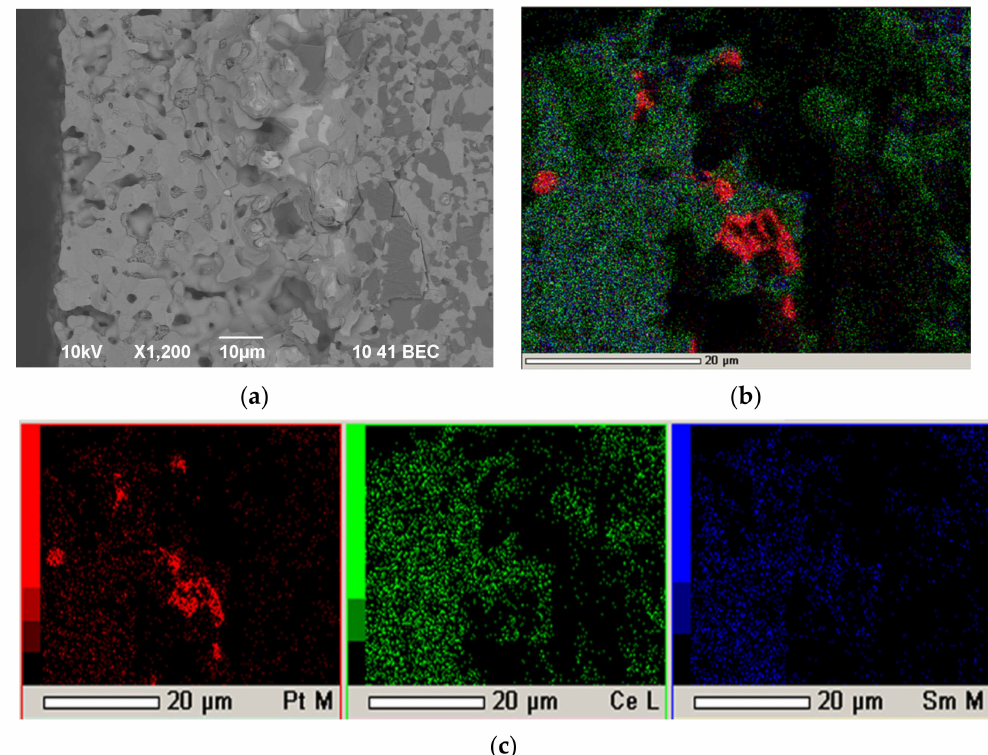
Figure 12. Cross-section of the SDC electrolyte layer after final sintering at a temperature of 1500 ◦ C for 5 h on a porous anode substrate with a platinum sublayer: ( a ) SEM image; ( b ) integral map of the elements’ distribution; ( c ) individual element